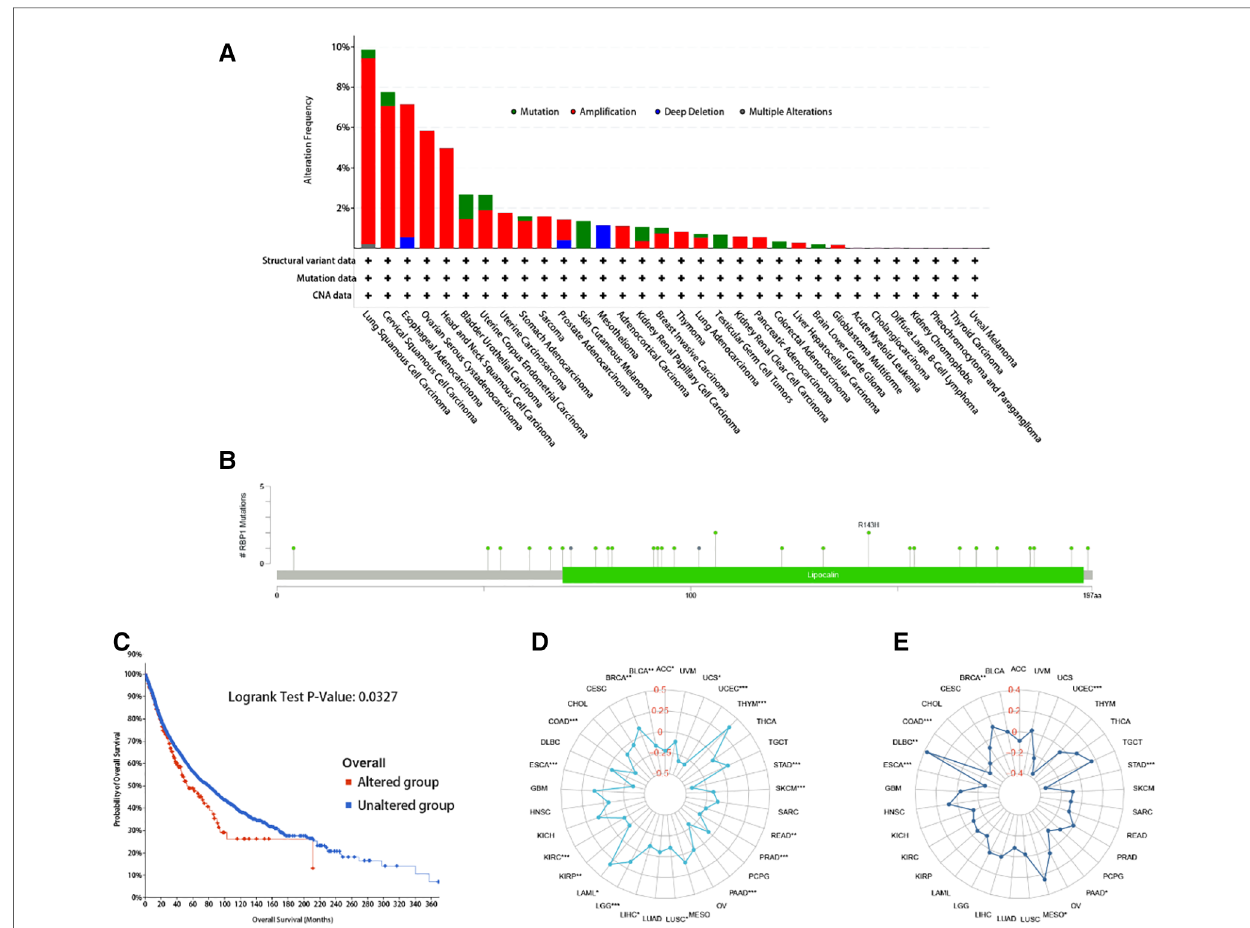
FIGURE 11 The RBP1 mutation signature landscape in TCGA. Each mutation type ’ s ( A ) and mutation site ’ s proportional frequency ( B ). ( C ) Kaplan – Meier plots showing the comparison of OS in cases with/without RBP1 gene alterations in Overall developed using the cBioPortal tool. The radargram of TMB ( D ), MSI ( E ), and RBP1 expressions in various